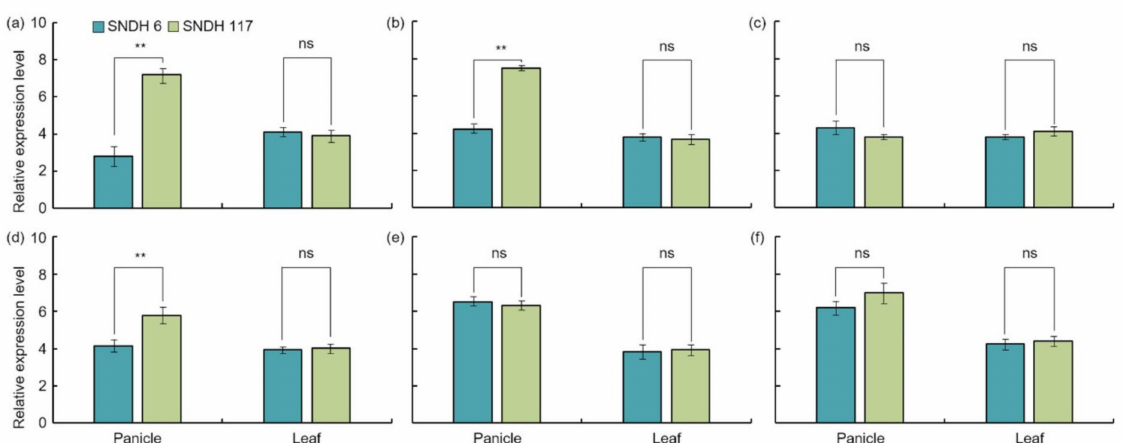
Figure 8. Comparison of relative gene expression levels in the leaves and panicles of the SNDH 6 and SNDH 117 lines, which had the smallest and largest grains, respectively, among the SNDH lines. There were no significant differences in any of the candidate genes in leaves. However, in the panicles, LOC_Os01g48444 and LOC_Os01g61690 were significantly different ( p < 0.05) between the SNDH 6 and SNDH 117 lines. Moreover, LOC_Os01g52050 was significantly different ( p < 0.01) between the SNDH 6 and SNDH 117 lines in the panicles. ns no significant; ** significant at the 0.01 level. ( a ) OsBRKq1 , ( b ) LOC_Os01g48444 , ( c ) LOC_Os01g53880 , ( d ) LOC_Os01g61690 , ( e ) LOC_Os02g42310 , and ( f ) LOC_Os02g46260